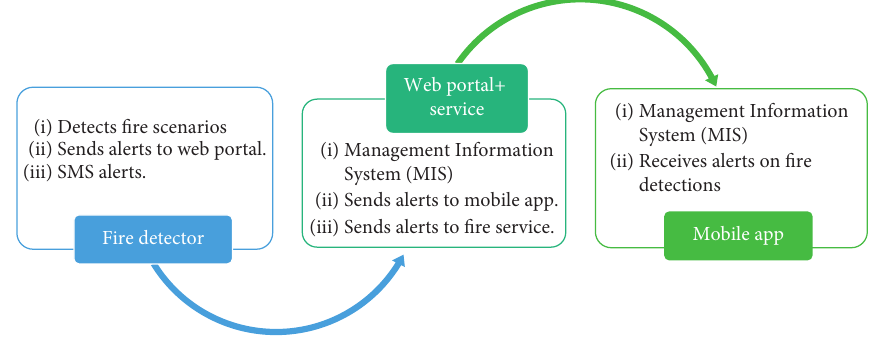
Figure 1: General overview of the system.